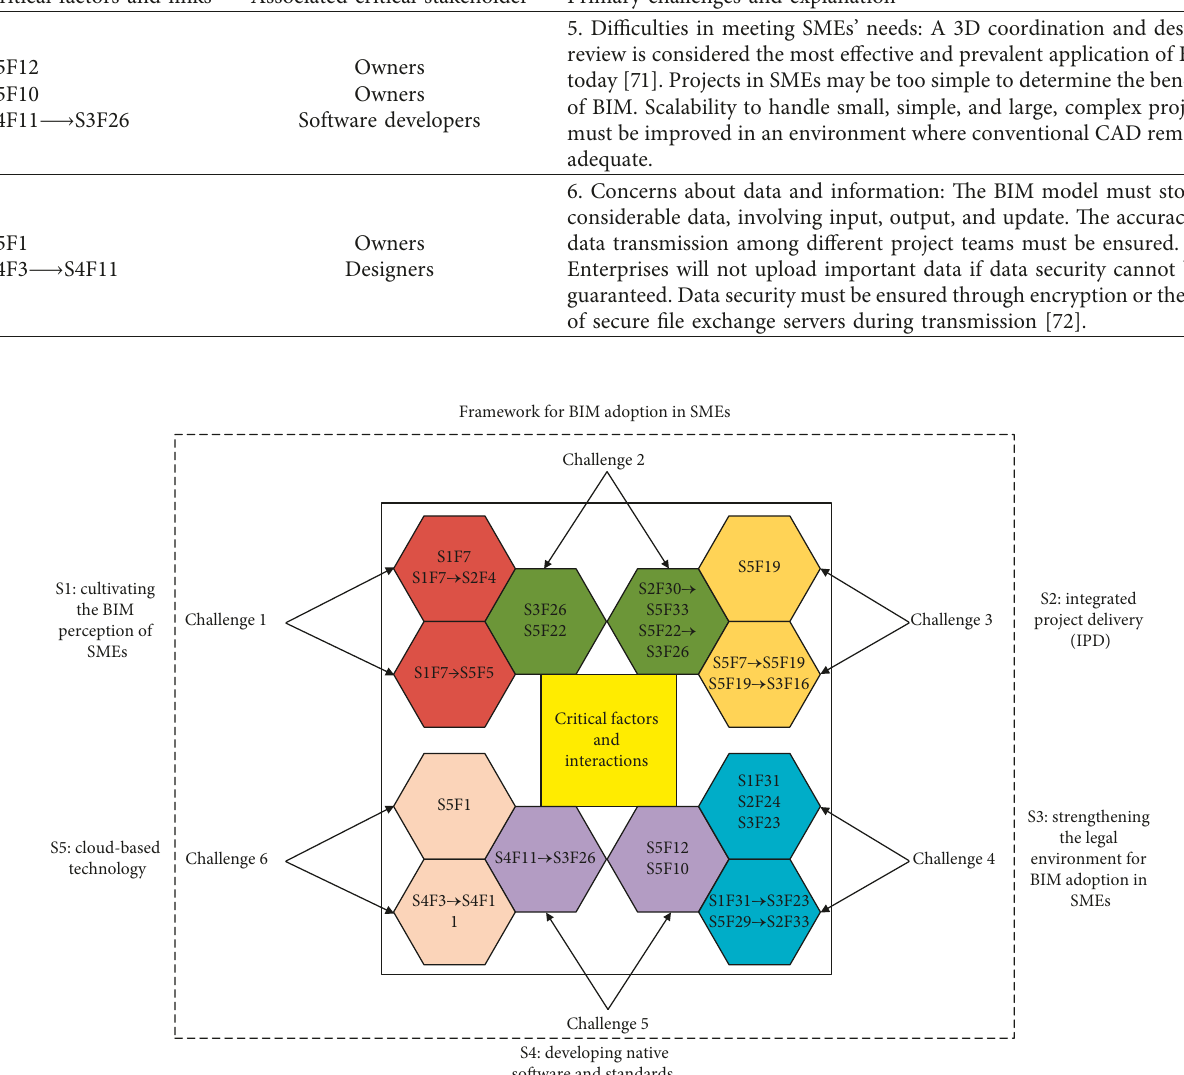
Figure 5: Framework for BIM adoption in